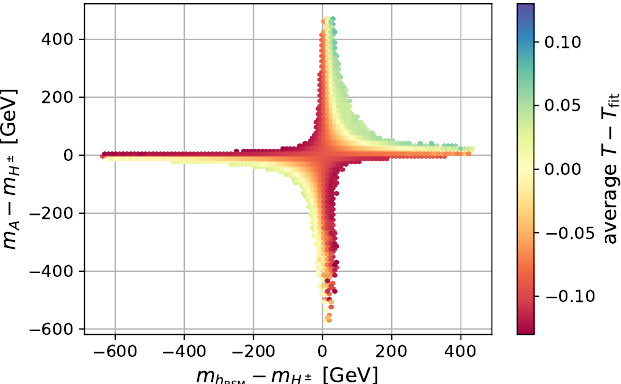
Figure 1. Possible mass separations between the charged Higgs boson and the non- h 125 neutral Higgs bosons. The color code indicates the (per-bin averaged) deviation of the T parameter from the central value of the fit from